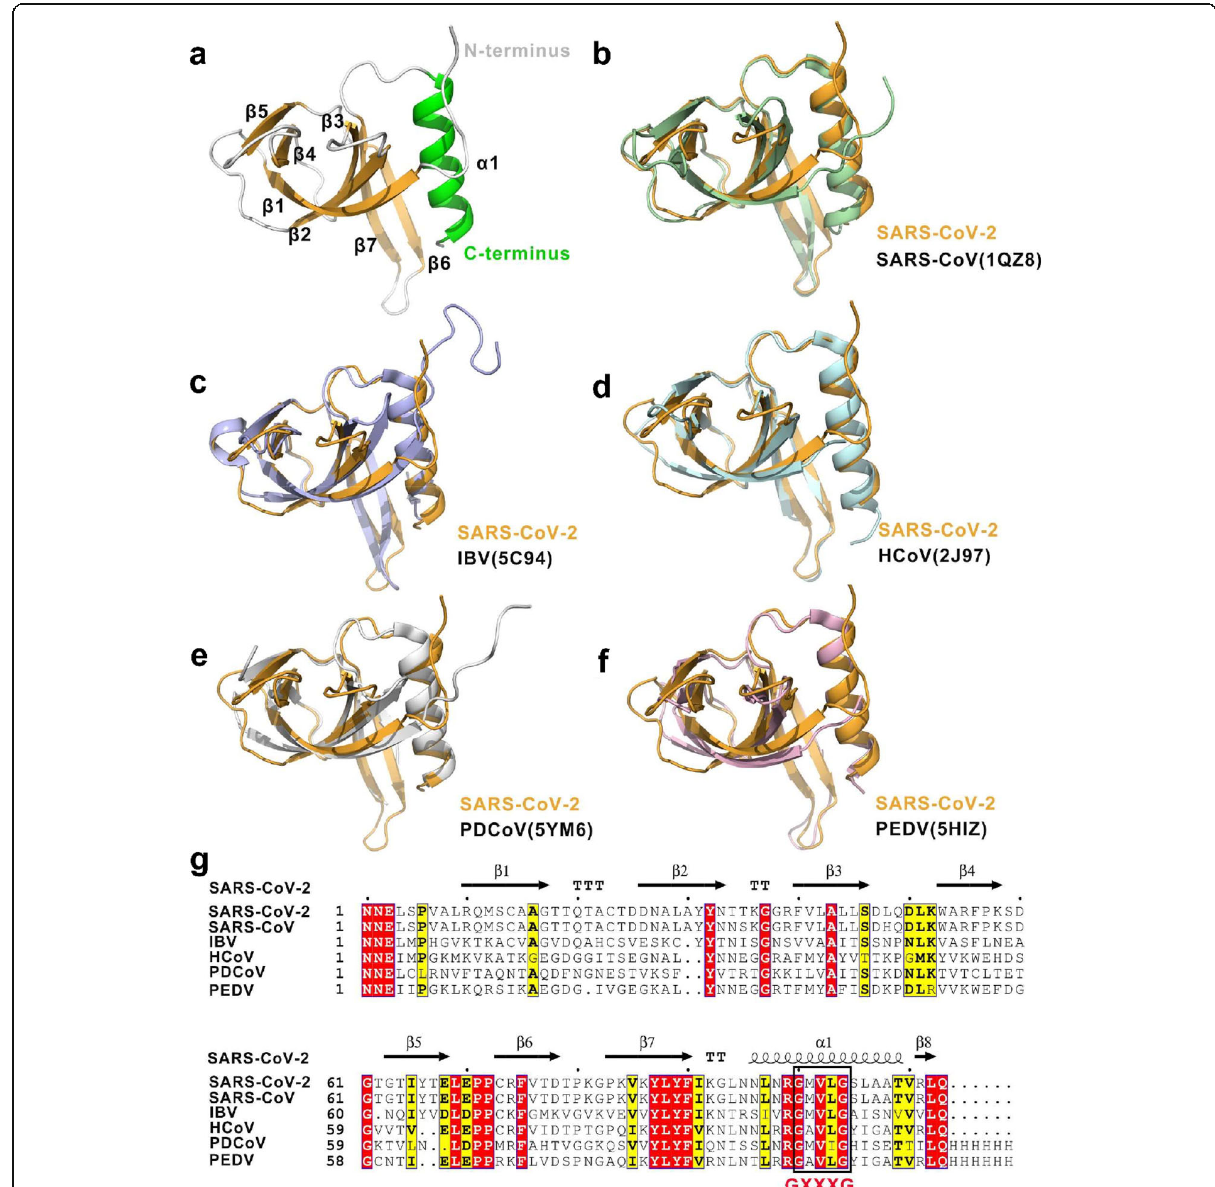
Fig. 1 Overall structure of the SARS-CoV-2 nsp9 protomer. a Different views of the protomeric architecture of SARS-CoV-2 nsp9 with the secondary structure labeled. The α -helix, β -sheets, and loops are colored in green, orange, and white, respectively. b – f Superimposition of SARS- CoV-2 nsp9 with other nsp9 structures in the coronavirus family. The nsp9s from SARS-CoV-2, SARS-CoV, avian infectious bronchitis virus (IBV), human coronavirus 229E (hCoV-229E), porcine delta coronavirus (PDCoV), and porcine epidemic diarrhea virus (PDEV) are colored in orange, light blue, marine, white, and salmon, respectively. The PDB codes are indicated in the lower right corner. g Sequence alignment of CoV nsp9 homologs. Comparison of the SARS-CoV, IBV, HCoV, PDCoV, and PDEV sequences with the SARS-CoV-2 sequence. Identical residues are highlighted in red, and conserved residues are shown in yellow. The table was produced with ESPript 3.0, using secondary structure elements for SARS-CoV-2 nsp9 assigned using DSSP. Residues boxed in red are completely